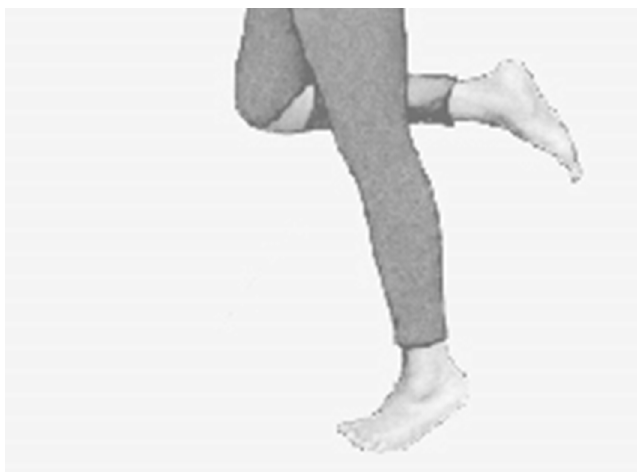
Figure 1. Performance of a Heel-Rise repetition.